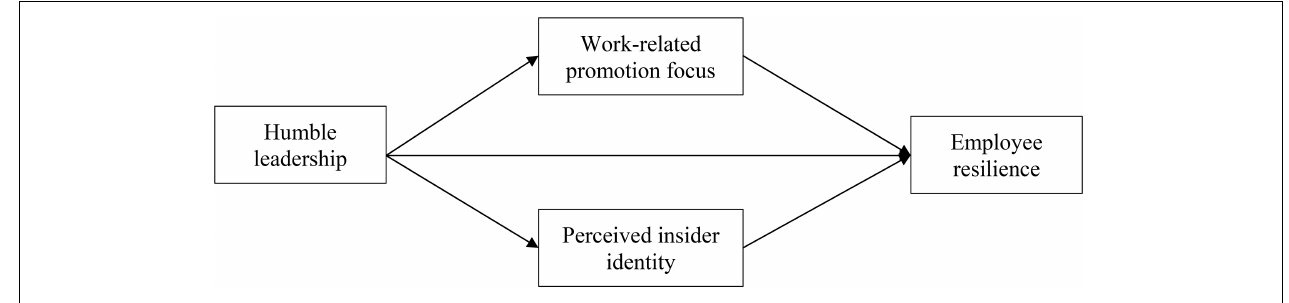
FIGURE 1 | Theoretical